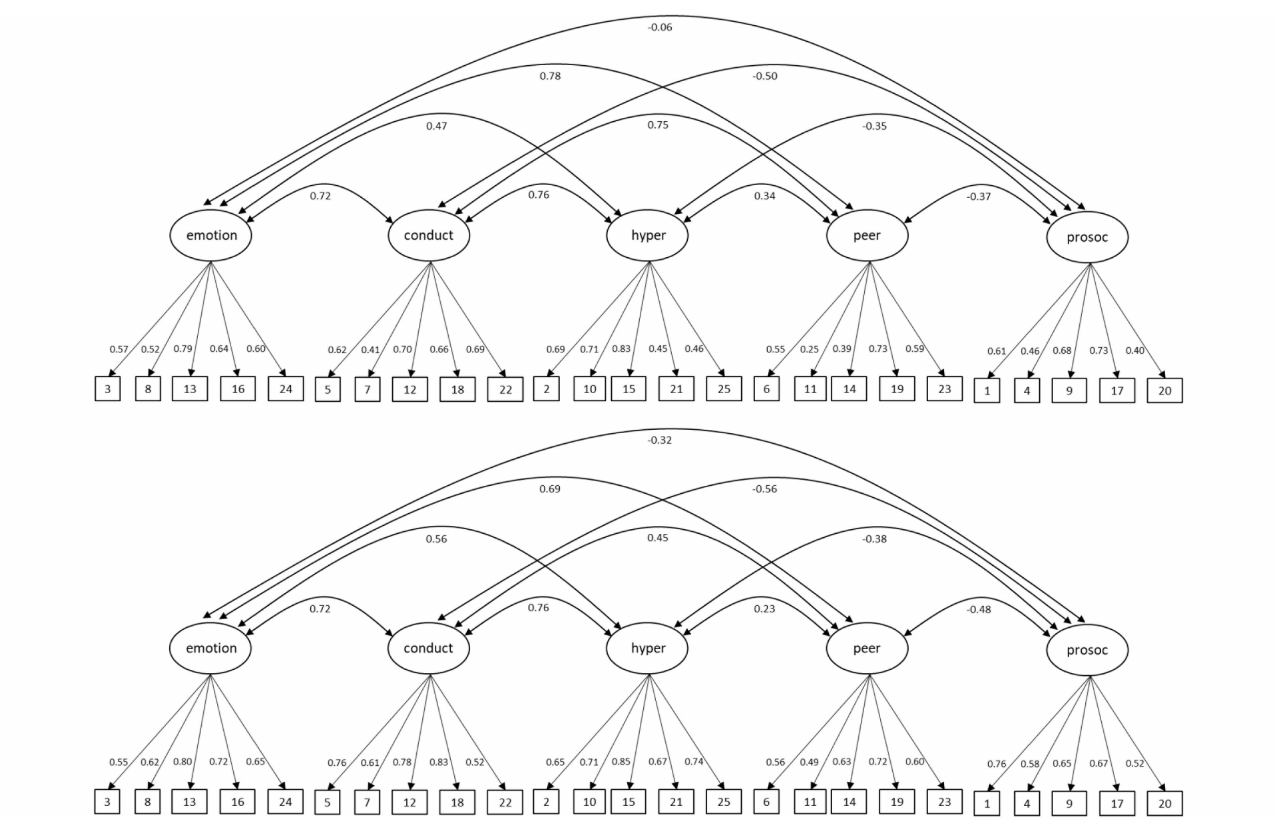
Fig 2. CFA parameters of the SDQ for self- and parent- reports (n = 1,284).